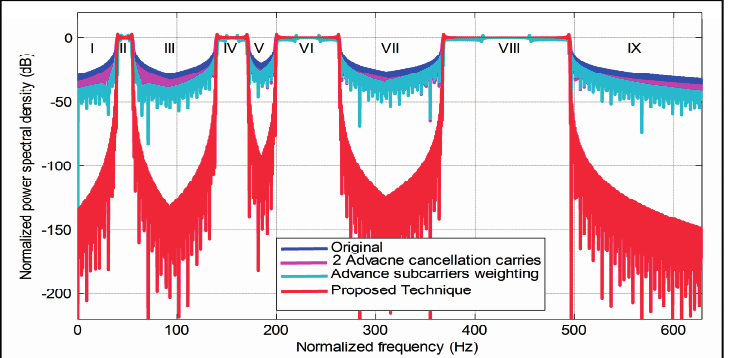
Figure 12. The PSD comparison between the proposed technique and existing techniques including ACC and